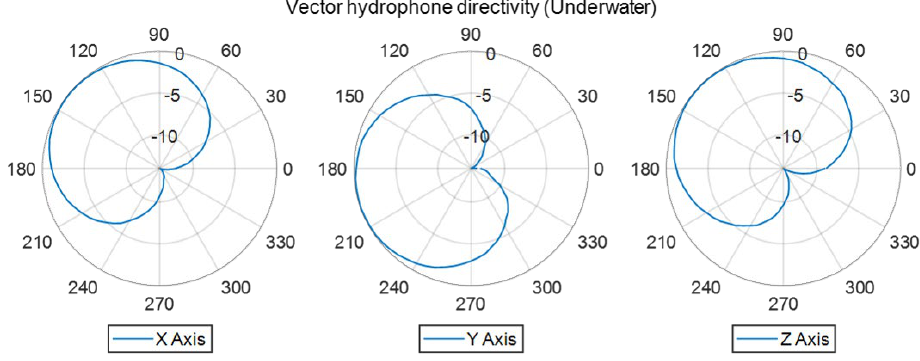
Figure 12. Cardioid patterns were measured underwater at a normalized frequency of 2.5.